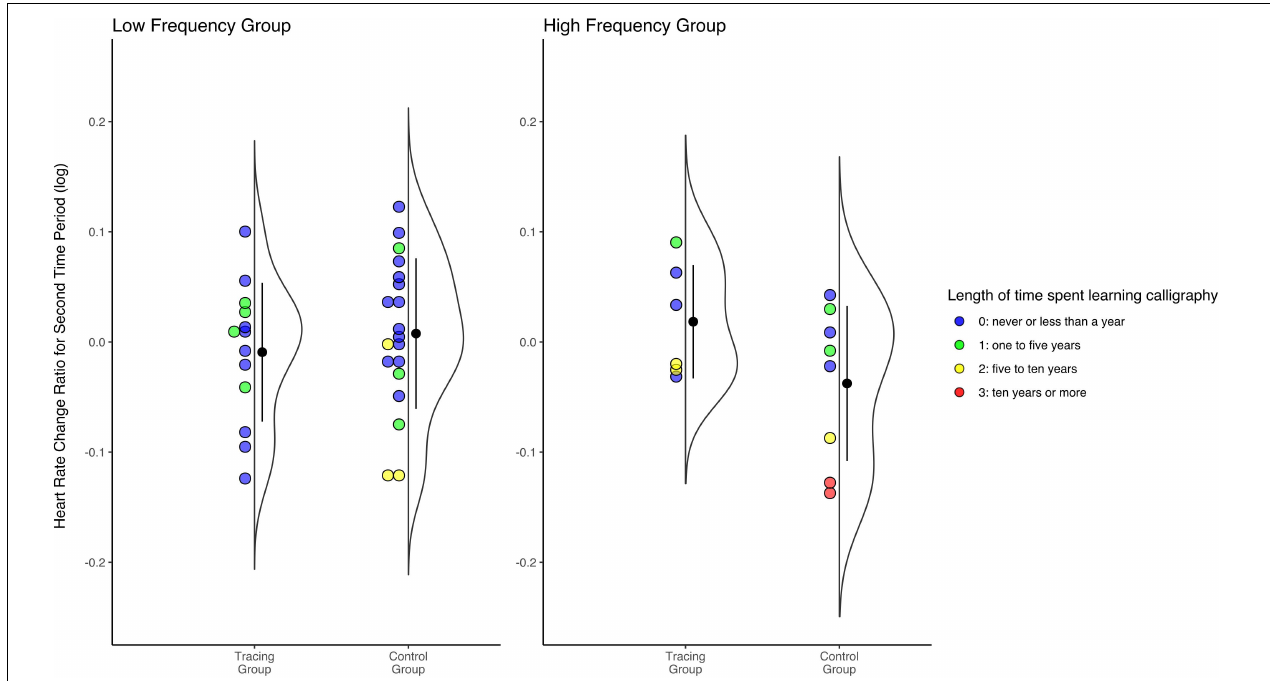
FIGURE 7 | Plot showing distributions of heart rate change ratio for the second time period in both groups of low frequency (left) and high frequency (right) of viewing calligraphy. Each dot represents individual values (color-coded by the length of time spent learning calligraphy). Violin plots to the right of the colored dot plots depict distributions of corresponding data, using the “geom_flat_violin” function (Robinson, 2015). Black dots and bars in violin plots represent each mean and standard